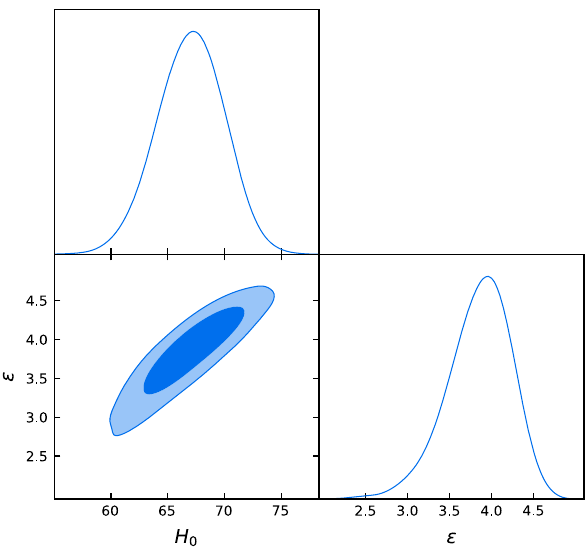
Fig. 2 The corner plot for the toy model (83)